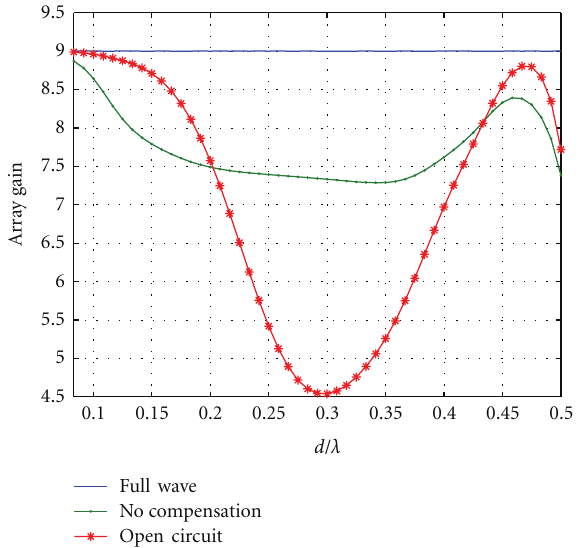
Figure 6: Array gain using the open-circuit voltage method as a function of the electrical separation ( d/λ ) between the elements of the nine-dipole planar array for a signal arriving from φ = 0 ◦ . Maximum gain is achieved as d/λ → 0. The implementation of the open-circuit voltage method yields a degradation in performance between d ≈ 0 . 2 λ and d ≈ 0 . 43, where the gain reaches lower magnitudes than those of the uncompensated case.